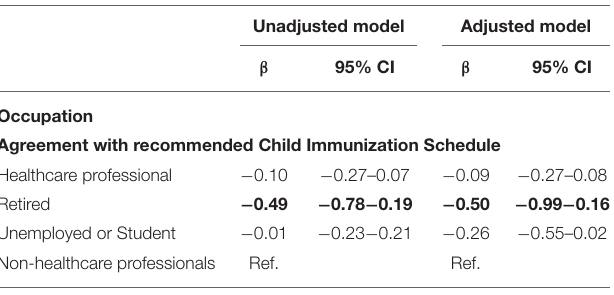
TABLE 3 | Associations between agreement with current Child Immunization Schedule and occupational status. Results from Generalized Linear Mixed